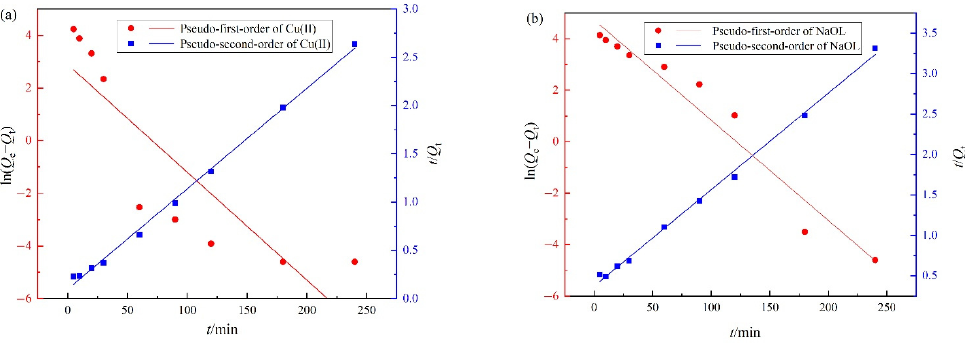
Figure 3. Fitting curves of adsorption kinetics for ( a ) Cu(II) and ( b ) NaOL on SiO 2 –g–PBMA–b–PDMAEMA. Table 3. Fitting parameters of adsorption kinetics for Cu(II) and NaOL on SiO 2 –g–PBMA–b– PDMAEMA.